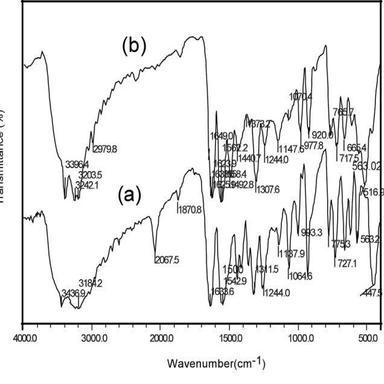
FTIR spectrum of ATZC crystal.